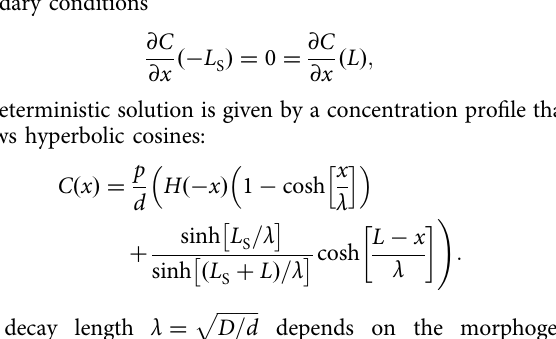
depends on the morphogen